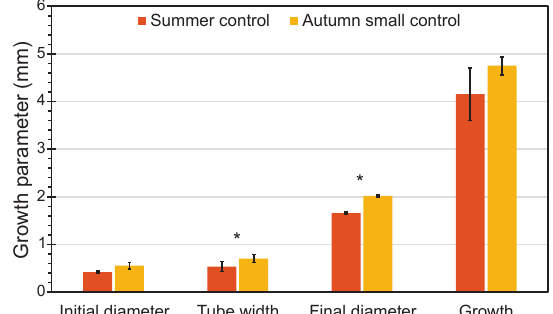
Figure 15. Size and growth of juvenile populations in control treat- ments of summer and autumn experiments. Two-way ANOVA and Tukey’s HSD tests; ∗ significant difference ( p < 0 .